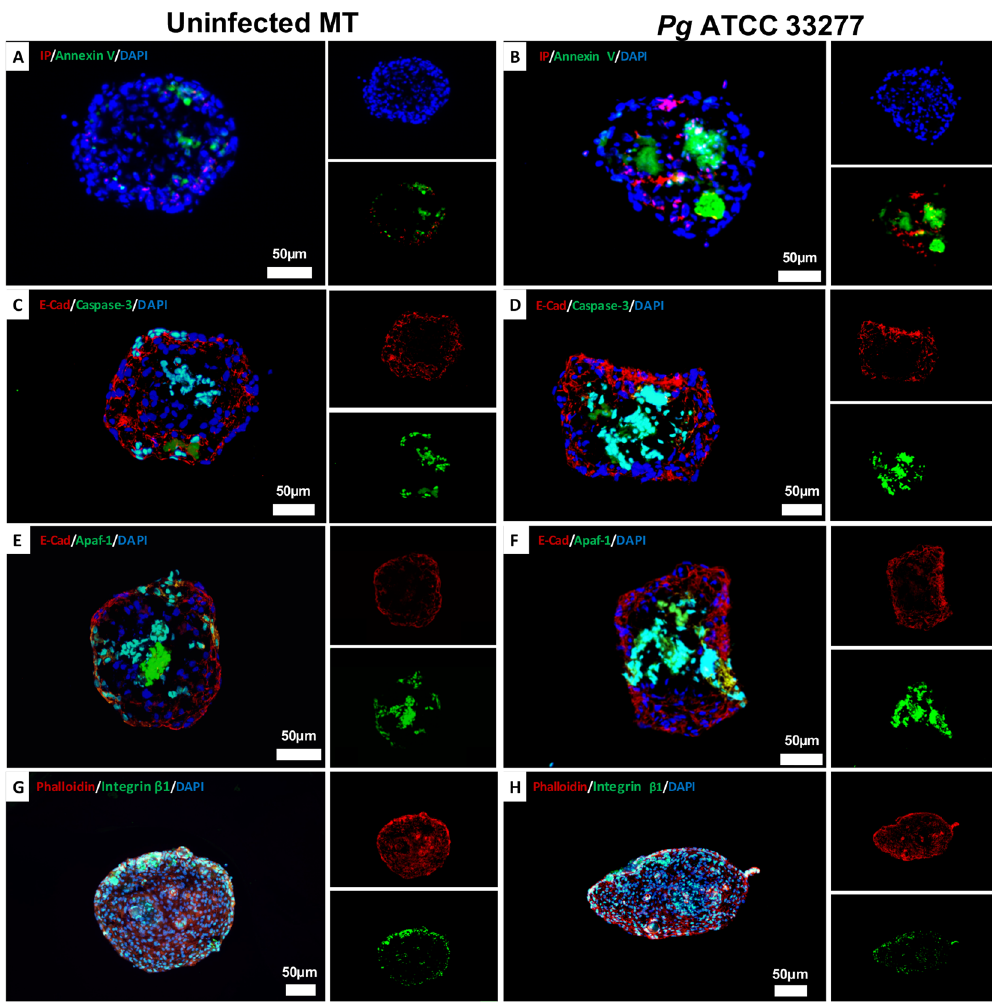
Figure 6. P. gingivalis infection induces an inflammatory response in MT correlated to an increased cell death. ( A ) Annexin V/IP fluorescence staining image in uninfected MT, ( B ) Annexin V/IP fluorescent staining images of MT infected with P. gingivalis for 24 h, ( C , D ) Immunofluorescence staining of uninfected MT ( C ) and infected with P. gingivalis ( D ) for 24 h (green: caspase-3, red: E-cadherin, blue: DAPI – nuclear staining), ( E , F ) Immunofluorescence staining of uninfected MT ( E ) and infected with P. gingivalis ( F ) for 24 h (green: APAF-1, red: E-cadherin, blue: DAPI – nuclear staining). ( G , H ) Immunofluorescence staining of uninfected MT ( G ) and infected with P. gingivalis ( H ) for 24 h (green: integrin β 1, red: E-cadherin, blue: DAPI – nuclear staining). All images were acquired at 20x